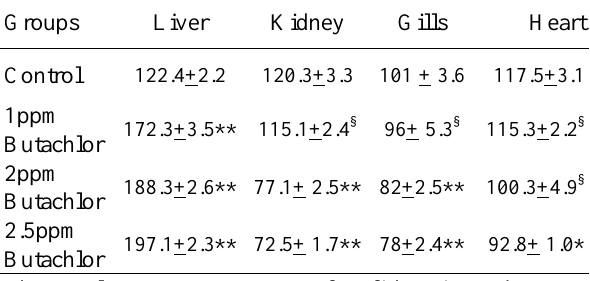
Table 5: The activity of Glutathione S-transferase (nmoles /min/mg protein) in the liver, kidneys, gills and heart of Clarias gariepinus exposed to Butachlor Groups